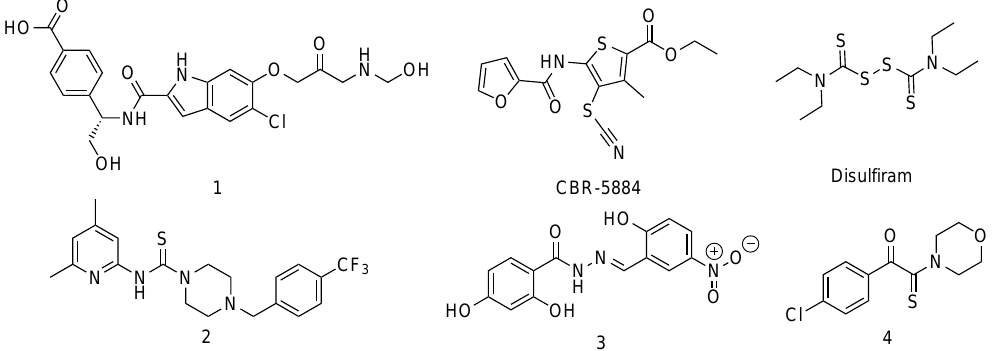
Figure 8. Structure of currently known inhibitors of human PHGDH that could be used in order to design inhibitors of